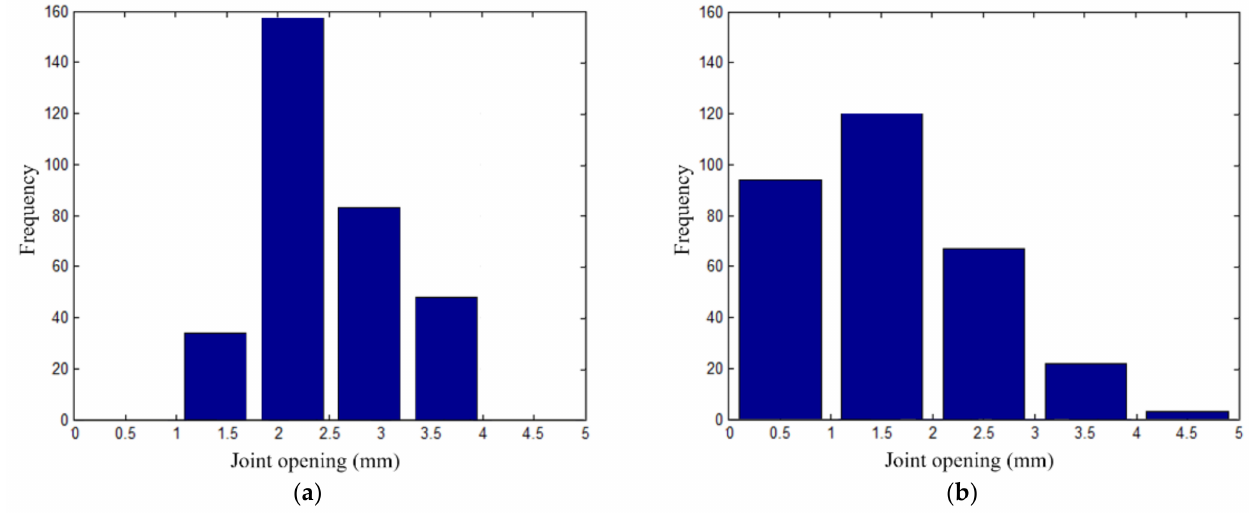
Figure 21. Error frequency distribution of the maximum joint openings in a ring measured at the forming tunnel. ( a ) Maximum circumferential joint opening; ( b ) Maximum longitudinal joint